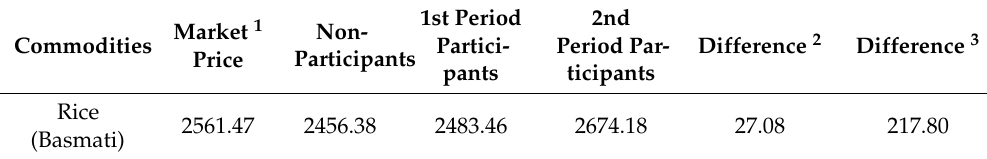
Table 7. Variation in producer prices among smallholders. Market Commodities